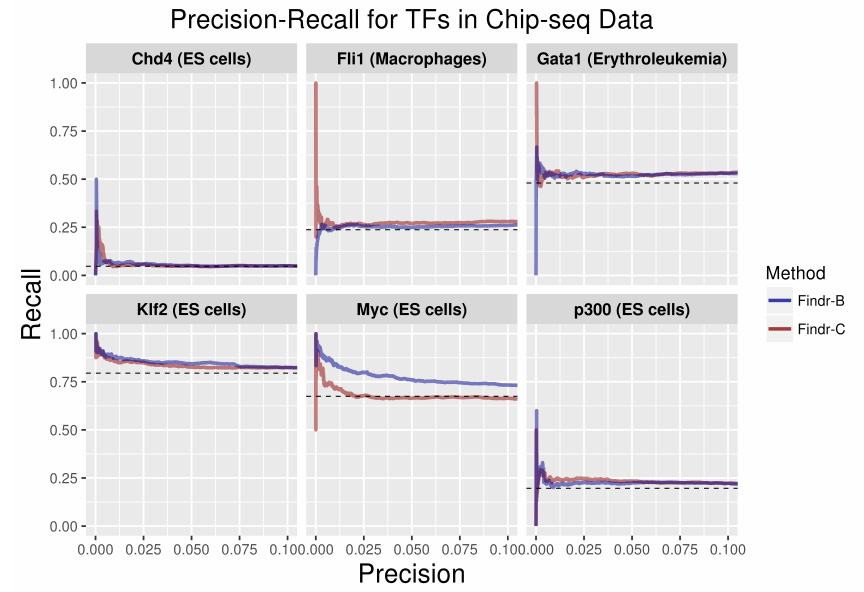
Figure 2. Recall-precision curves for target predictions by Findr-B and Findr-C using ChIP-seq. The dotted line represents the background or the the random classifier precision.